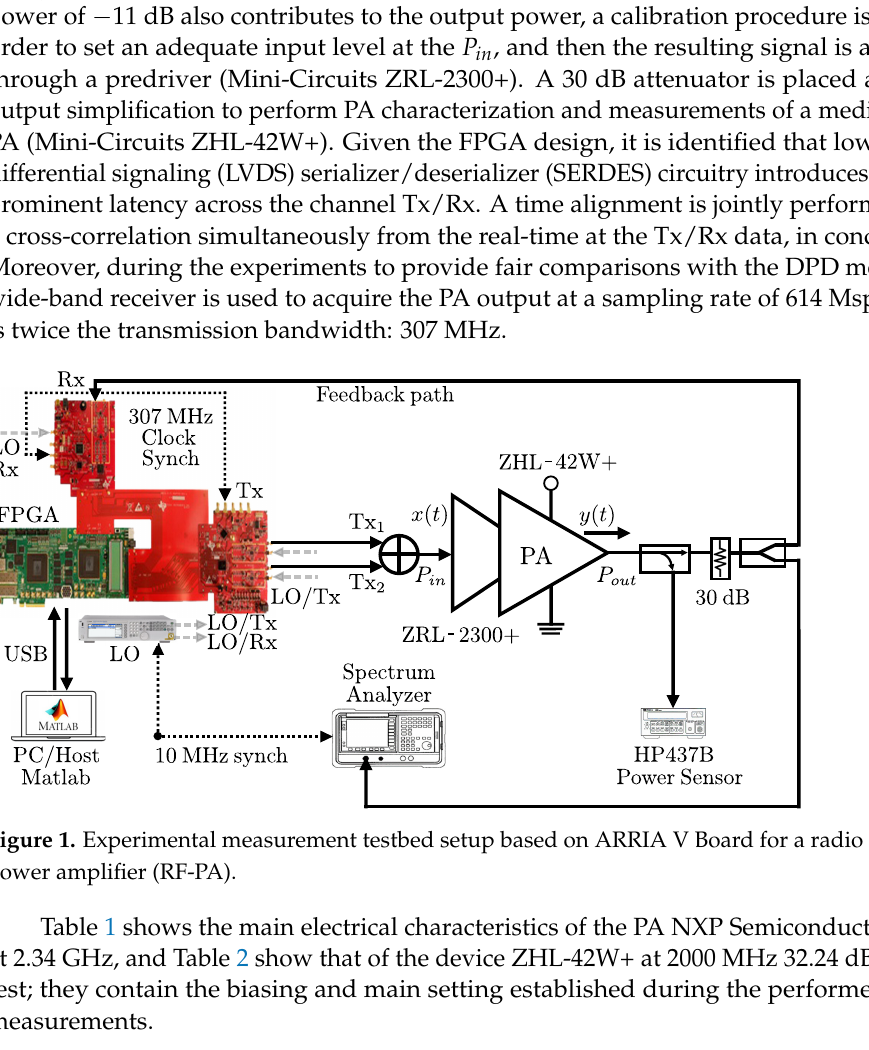
Table 1. Features of the NXP 10 W